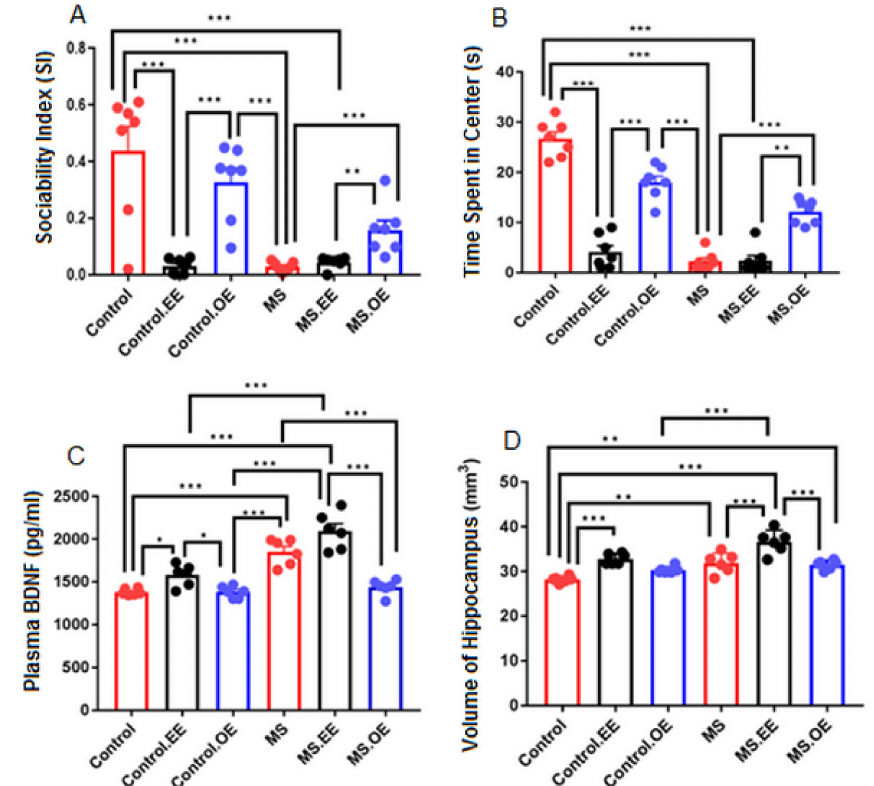
Figure 9. Effects of oxytocin on the negative effects of EE on the social index ( n = 10) ( A ), anxiety ( n = 10) ( B ), plasma BDNF level ( n = 6) ( C ) and volume of the hippocampus ( n = 6) ( D ). * p < 0.05, ** p < 0.01, *** p < 0.001. Data for plasma BDNF and hippocampus volume are presented before log-transformation, MS: Maternal Separation, EE: Environmental